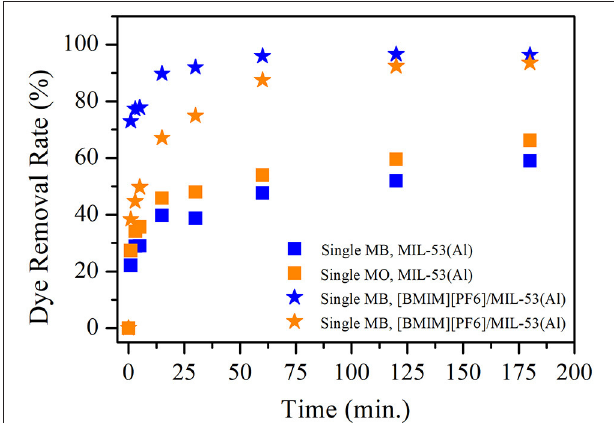
FIGURE 1 | MB and MO removal efficiencies of MIL-53(Al) (squares) and [BMIM][PF 6 ]/MIL-53(Al) (stars). Blue (orange) color represents MB (MO) removal for single dye. MB, methylene blue; MO, methyl orange.